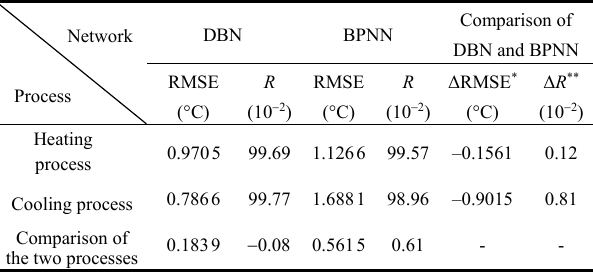
Table 3 Evaluation indexes of the prediction effect of DBN and